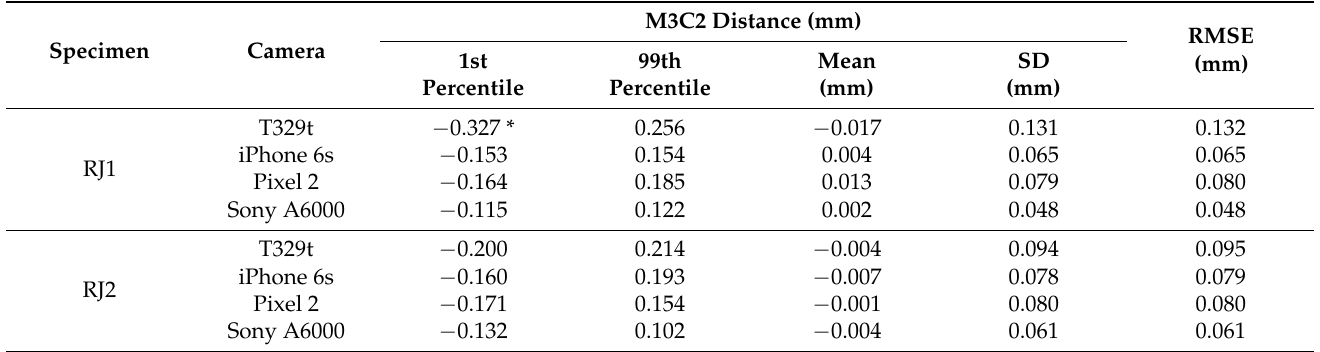
Table 7. The M3C2 distances between HLS model and SfM model under the MSC mode.